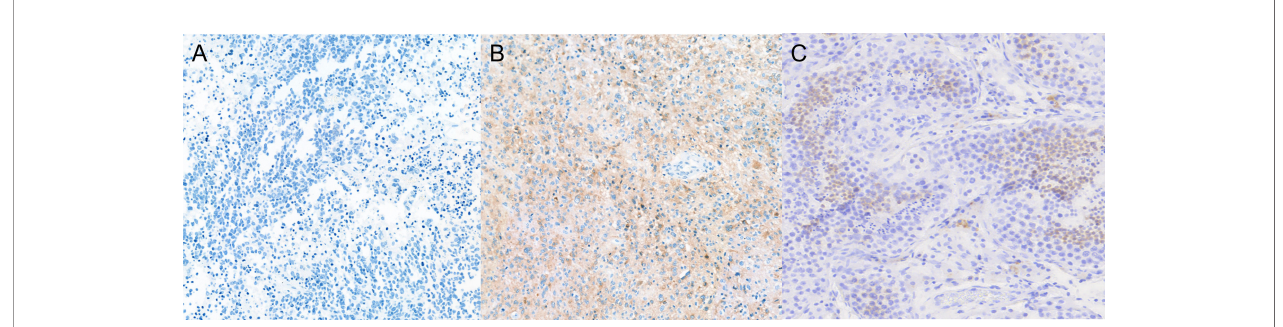
FIGURE 5 | Expression of IL13R a 2 in glioma and testes tissues. Glioma and testes tissues were stained with anti-IL13R a 2 antibody and HRP-conjugated secondary antibody. (A) H-score of 0 (0 intensity × 0% proportion). (B) H-score of 270 (3 intensity × 90% proportion). (C) Testes as a positive control (×100 magni fi cation). HRP, horseradish peroxidase.